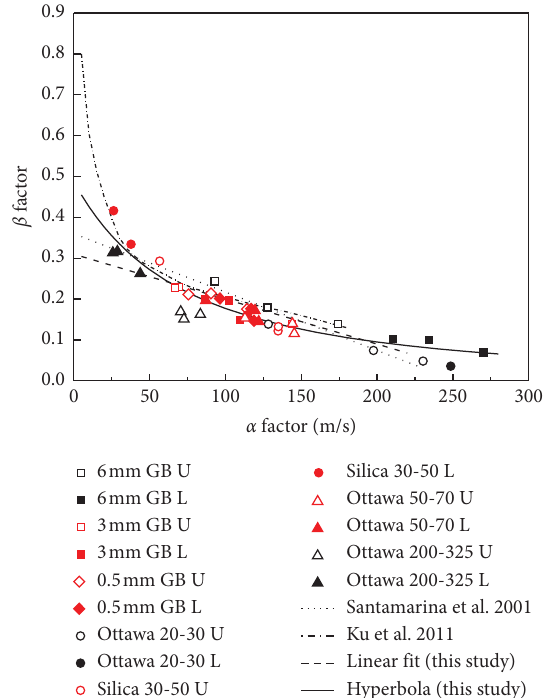
Figure 6: Fitted values of α and β coefficients for granular materials in this study. L: loading, in open symbol. U: unloading, in solid